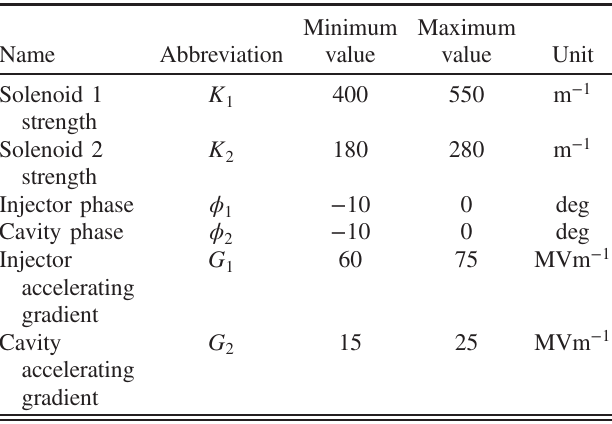
TABLE I. Range of the AWA input variables.